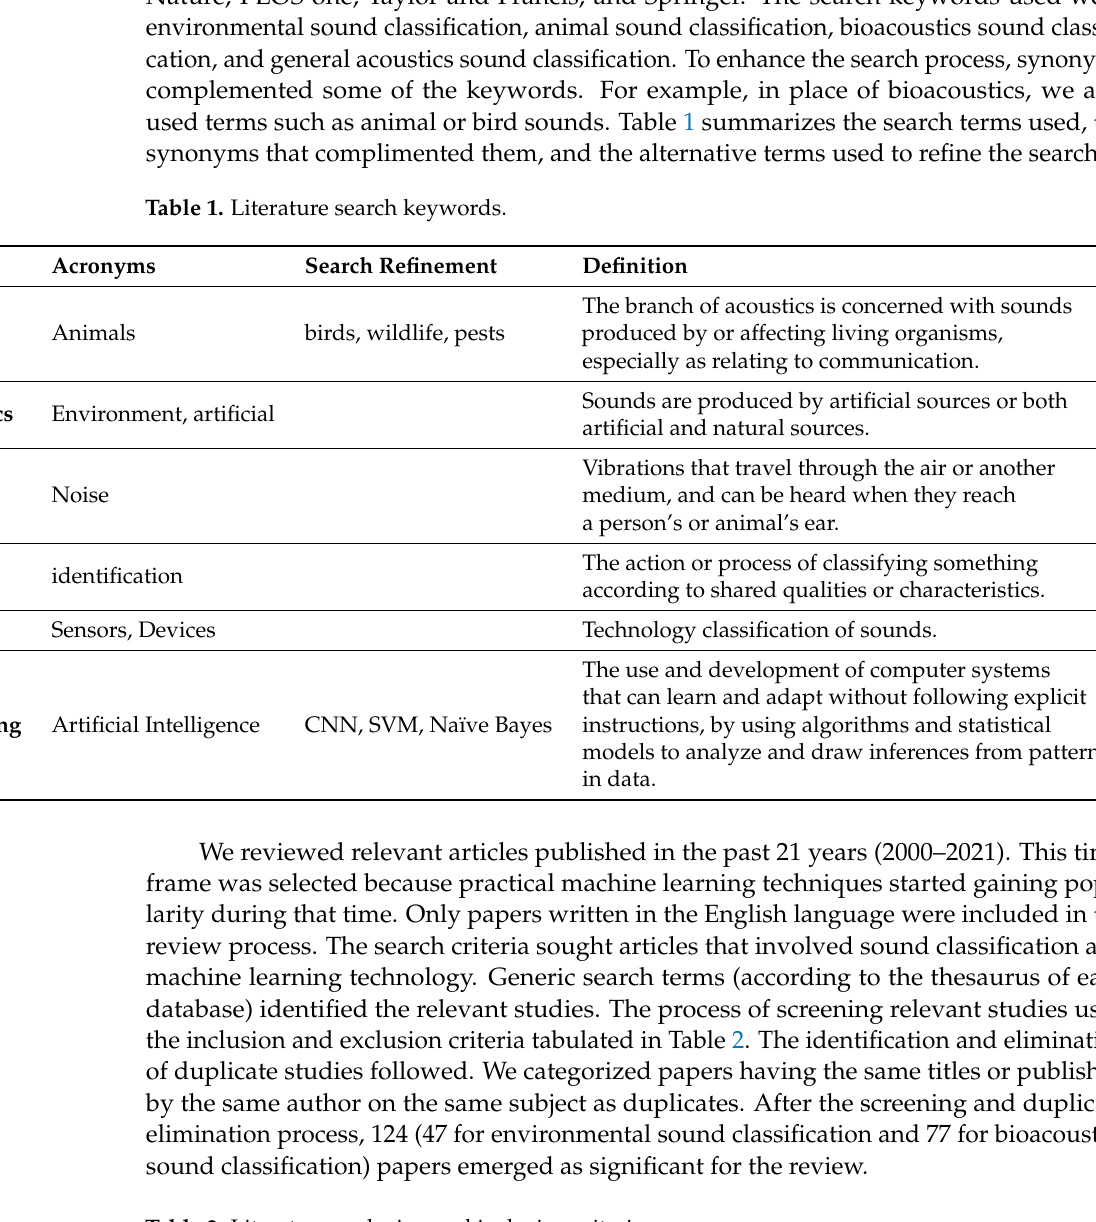
Table 2. Literature exclusion and inclusion